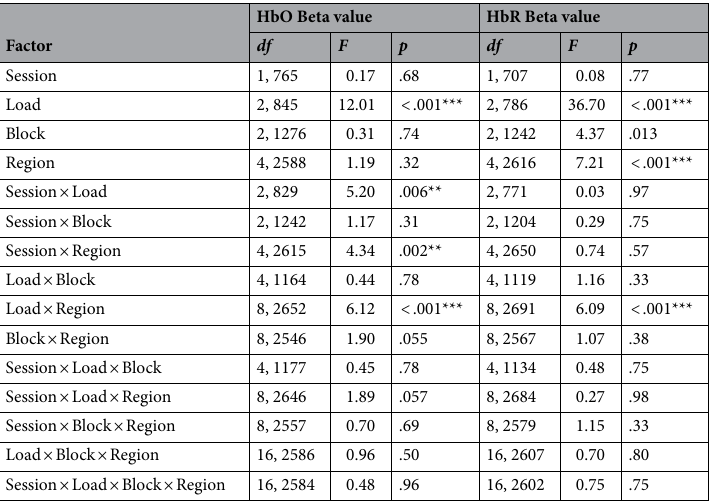
Table 5. Linear mixed model results for changes in oxyhemoglobin (HbO) and deoxyhemoglobin (HbR) concentrations. Asterisks indicate significant effects that survived false discovery rate correction. ** p < .01, *** p < .001.